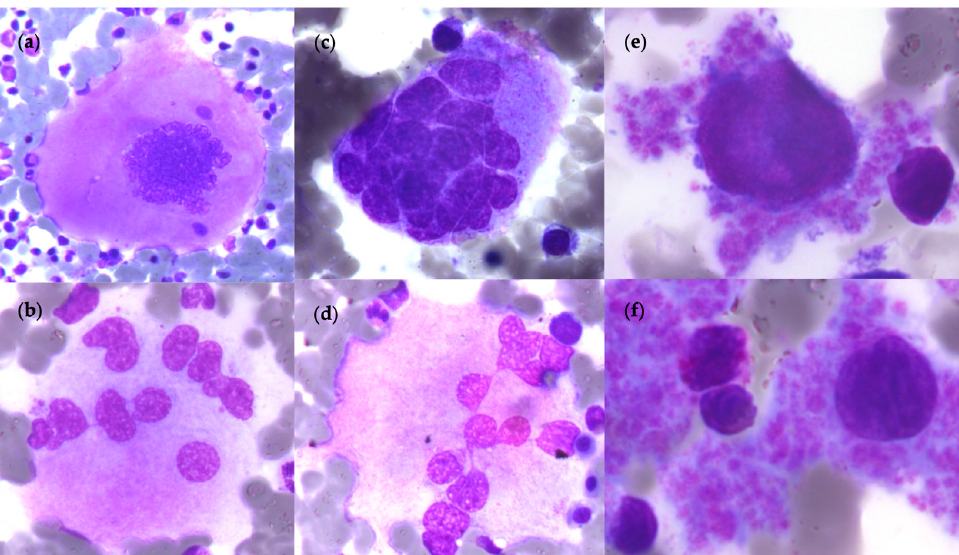
12 of 25 Figure 5. Blood smear in pre-PMF. Heterogeneity of platelets with macroplatelet (red arrows), giant platelet (purple arrow), degranulated macroplatelet (grey arrow) associated with teardrop-shaped RBC (black arrow). (Optical microscopy, May Grünwald Giemsa, ×100 magni fi cation). Due to this thrombocytosis, it is necessary to di ff erentiate pre-PMF from ET based on morphologic fi ndings in the BM biopsy as detailed in WHO 2022 classi fi cation. Pre-PMF demonstrates hypercellular BM with granulocytic proliferation with often erythropoiesis hypoplasia without dysplasia [15] and without immature cells excess, nor maturation blockade. Megakaryocytic abnormalities which are be tt er appreciated by the BM biopsy are the key factors for the diagnosis with analysis of topographical distribution in BM. There are numerous MKs with variable sizes (small to high), pleomorphic with aberrant